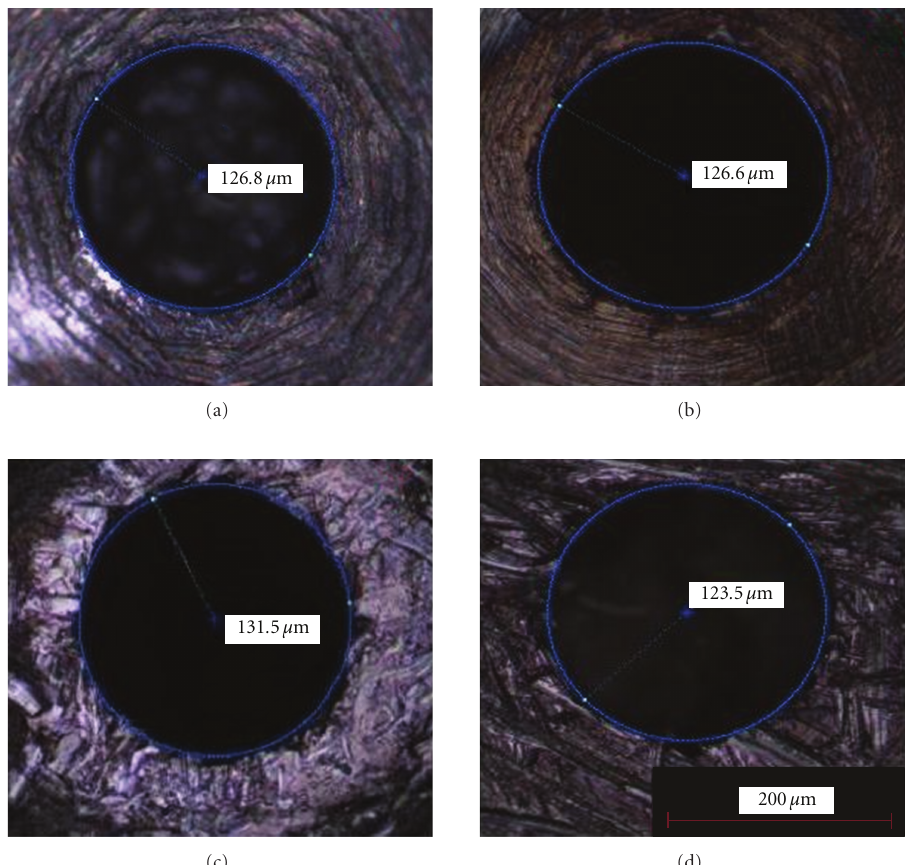
Figure 3: The nozzle outlet measurements with metallurgical microscope.